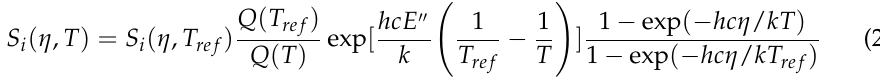
( 0 η is the central wave number of the ith spectral line. 0 i